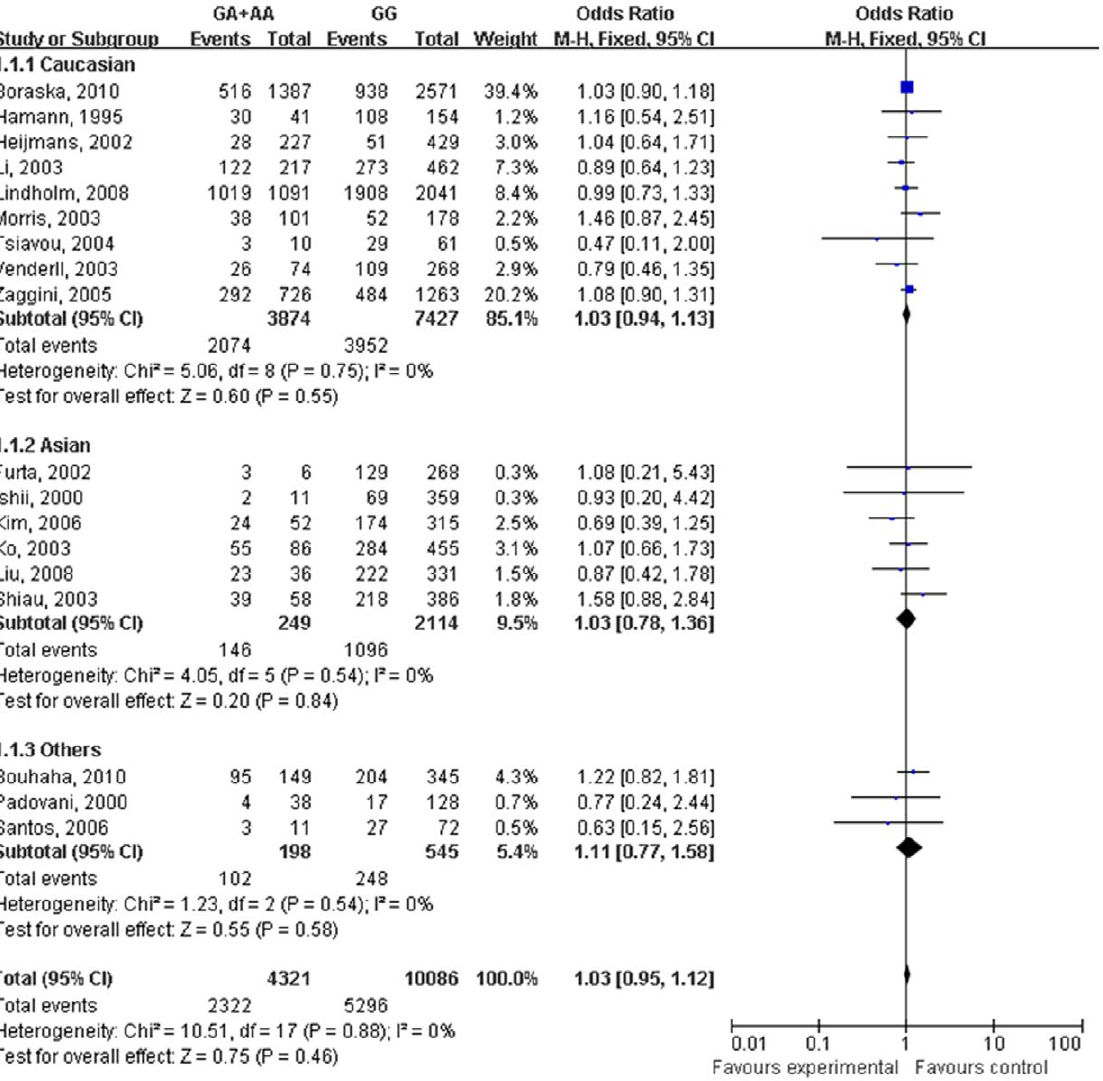
Figure 1. Meta-analysis of the association between TNF 308 G/A polymorphism and the risk for type 2 diabetes mellitus.